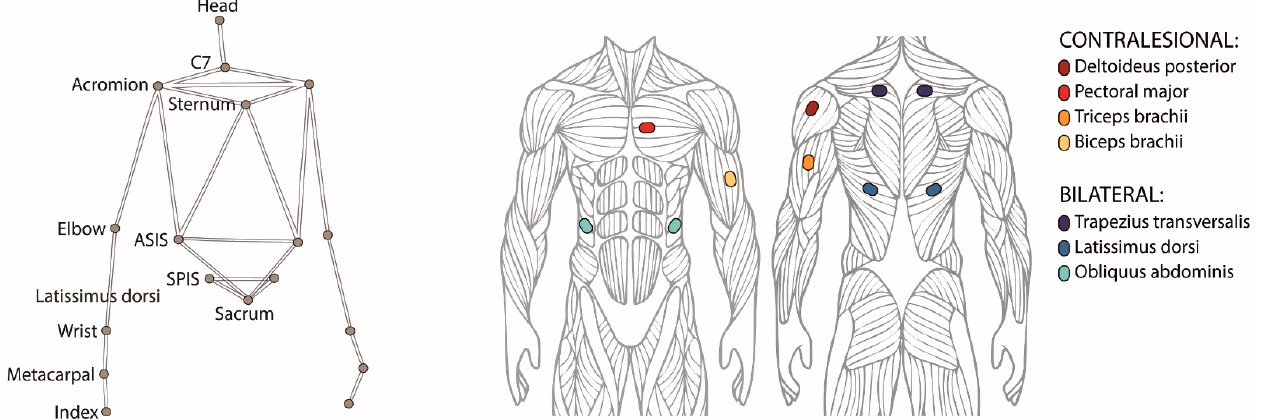
Figure 2. (left) Positions of the 18 reflective markers placed on the skin in correspondence of anatomical landmarks and used for recording the body motion with a motion capture system. (right) Muscles selected for recording the muscular activation patterns, four on the contralesional arm and three bilaterally on the torso.